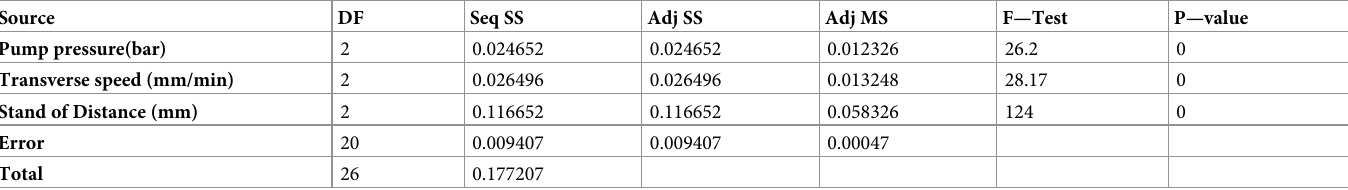
Table 8. ANOVA table for 0.2 wt. % filler loaded composite.